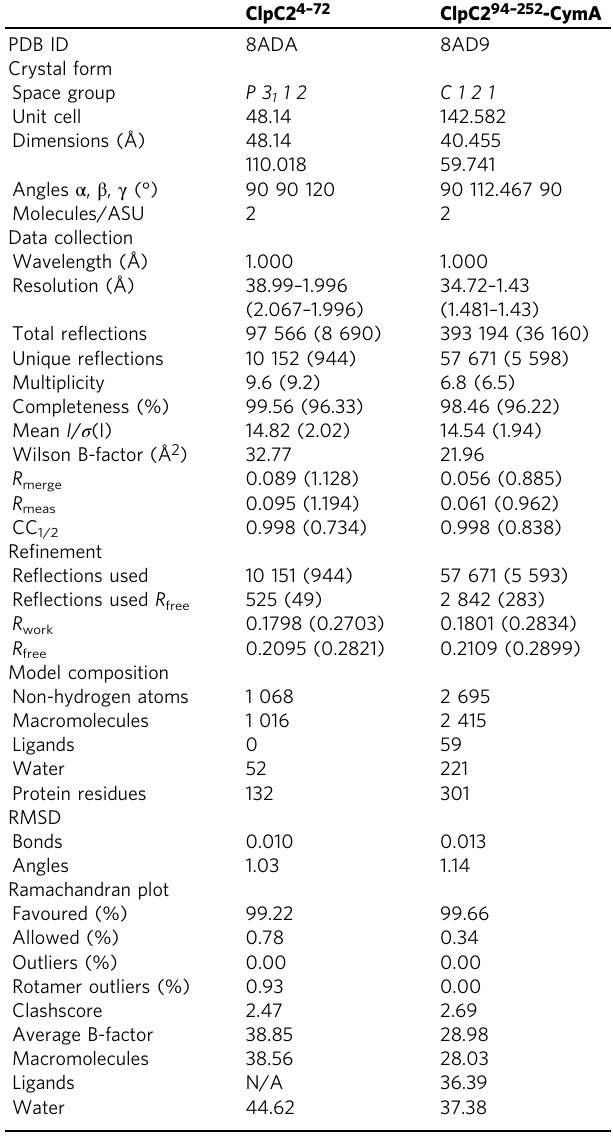
Table 1 Data collection and re fi nement